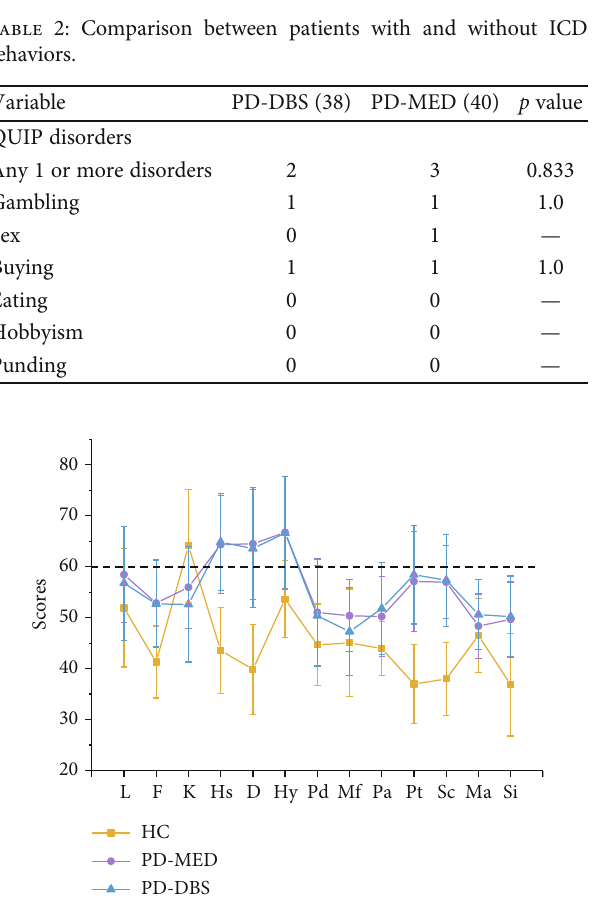
Figure 1: Scores of validity scales and personality scales in three groups of subjects. Note: HC: healthy control; PD-MED: drug- treated PD patients; PD-DBS: STN-DSB surgery; MMPI-1: Minnesota multiphasic personality inventory-1; L: lie; F: fake; K: